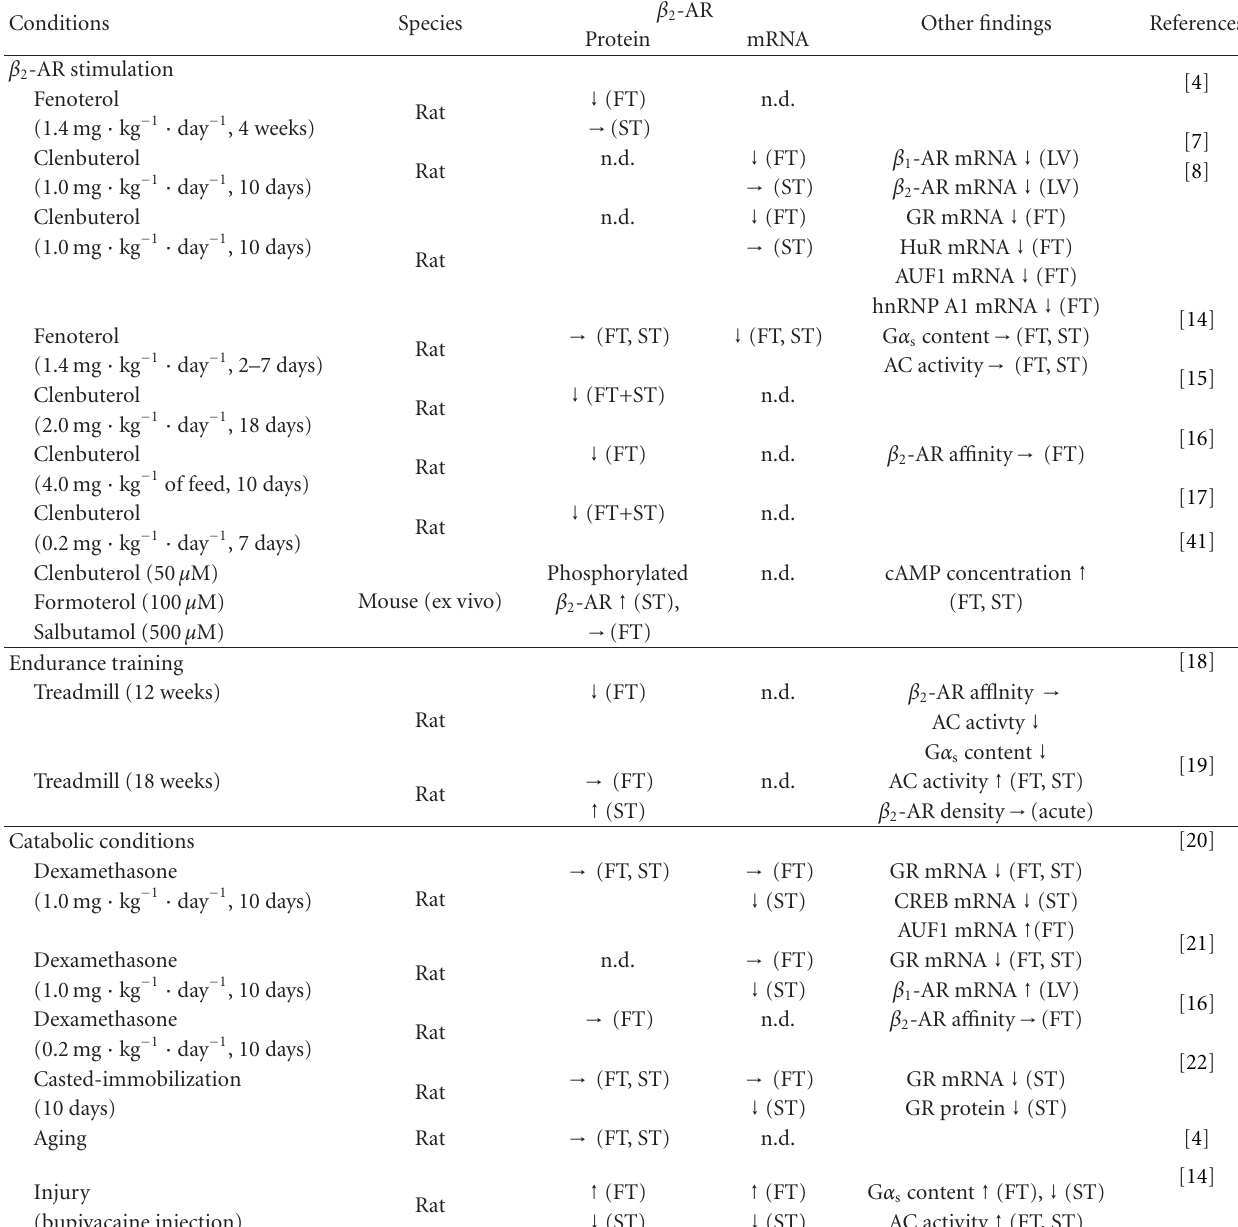
Table 1: Responses of β 2 -AR expression in skeletal muscle to anabolic and catabolic